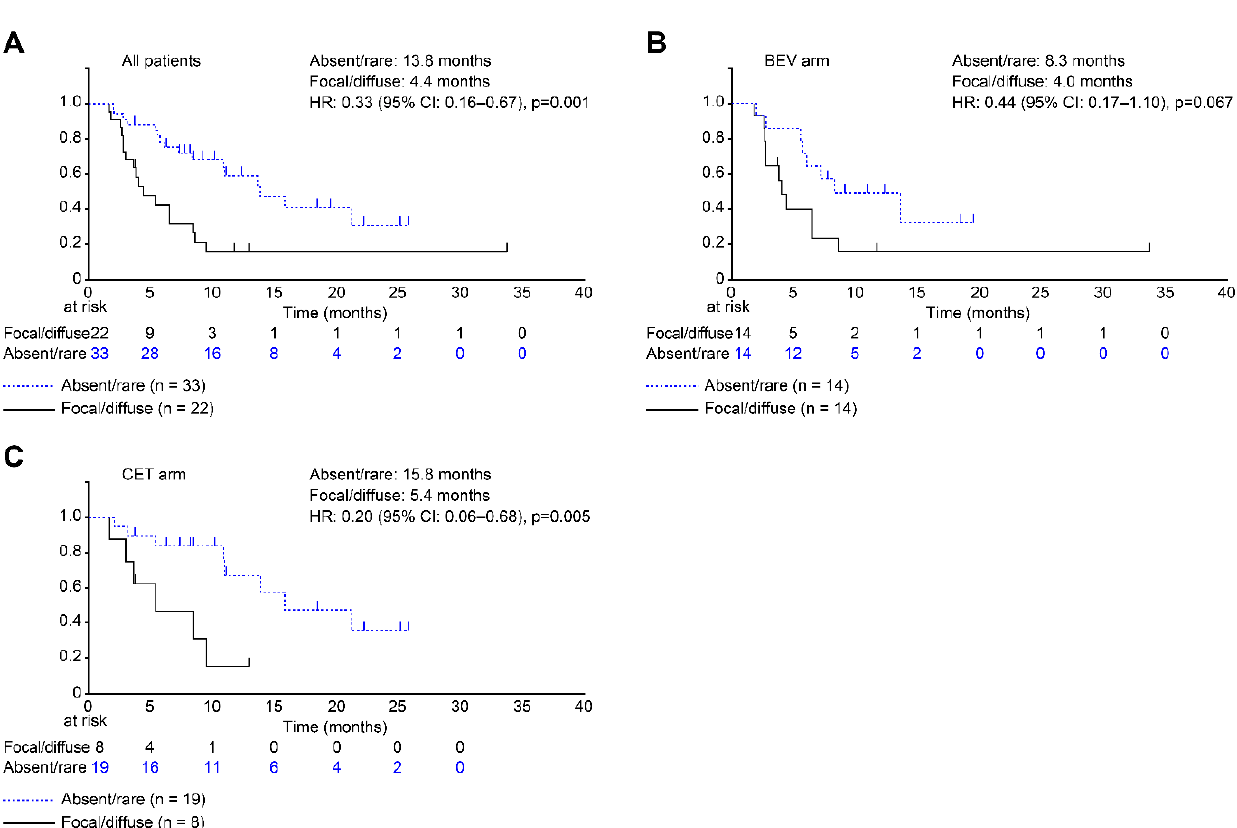
Figure 4. Kaplan–Meier curves for relapse-free survival (RFS, time to relapse after resection) according to the dangerous halo (DH) classification. Curves are shown for all patients ( A ), those in the bevacizumab (BEV) arm ( B ), and those in the cetuximab (CET) arm ( C ). Relative to the patients in the focal/diffuse classification, the patients in the absent/rare classification had significantly better RFS (median: 4.4 vs. 13.8 months; hazard ratio (HR): 0.33; 95% confidence interval (CI): 0.16–0.67; p = 0.001). Similarly, relative to the focal/diffuse classification, the absent/rare classification was associated with significantly better RFS in the BEV arm (median: 4.0 vs. 8.3 months; HR: 0.44; 95% CI: 0.17–1.10; p = 0.067) and in the CET arm (median: 5.4 vs. 15.8 months; HR: 0.20; 95% CI: 0.06–0.68; p = 0.005).